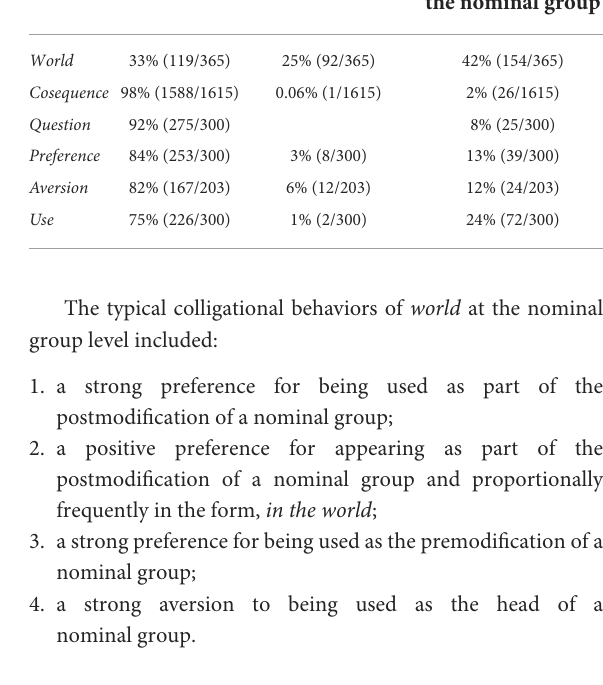
TABLE 11 A comparison of the grammatical distribution of world in the nominal group with words studied by Hoey (2005). Head